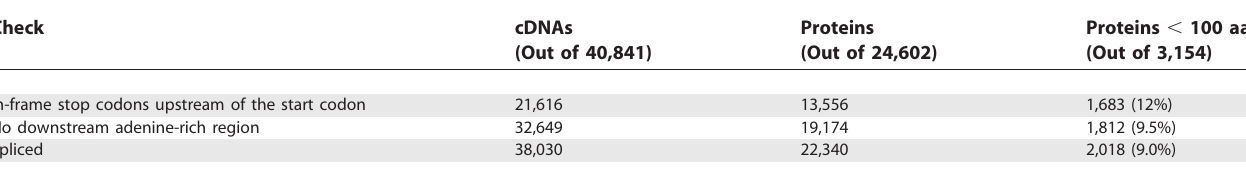
Table 2. Checks of the Genome-Confirmed CDS Predictions